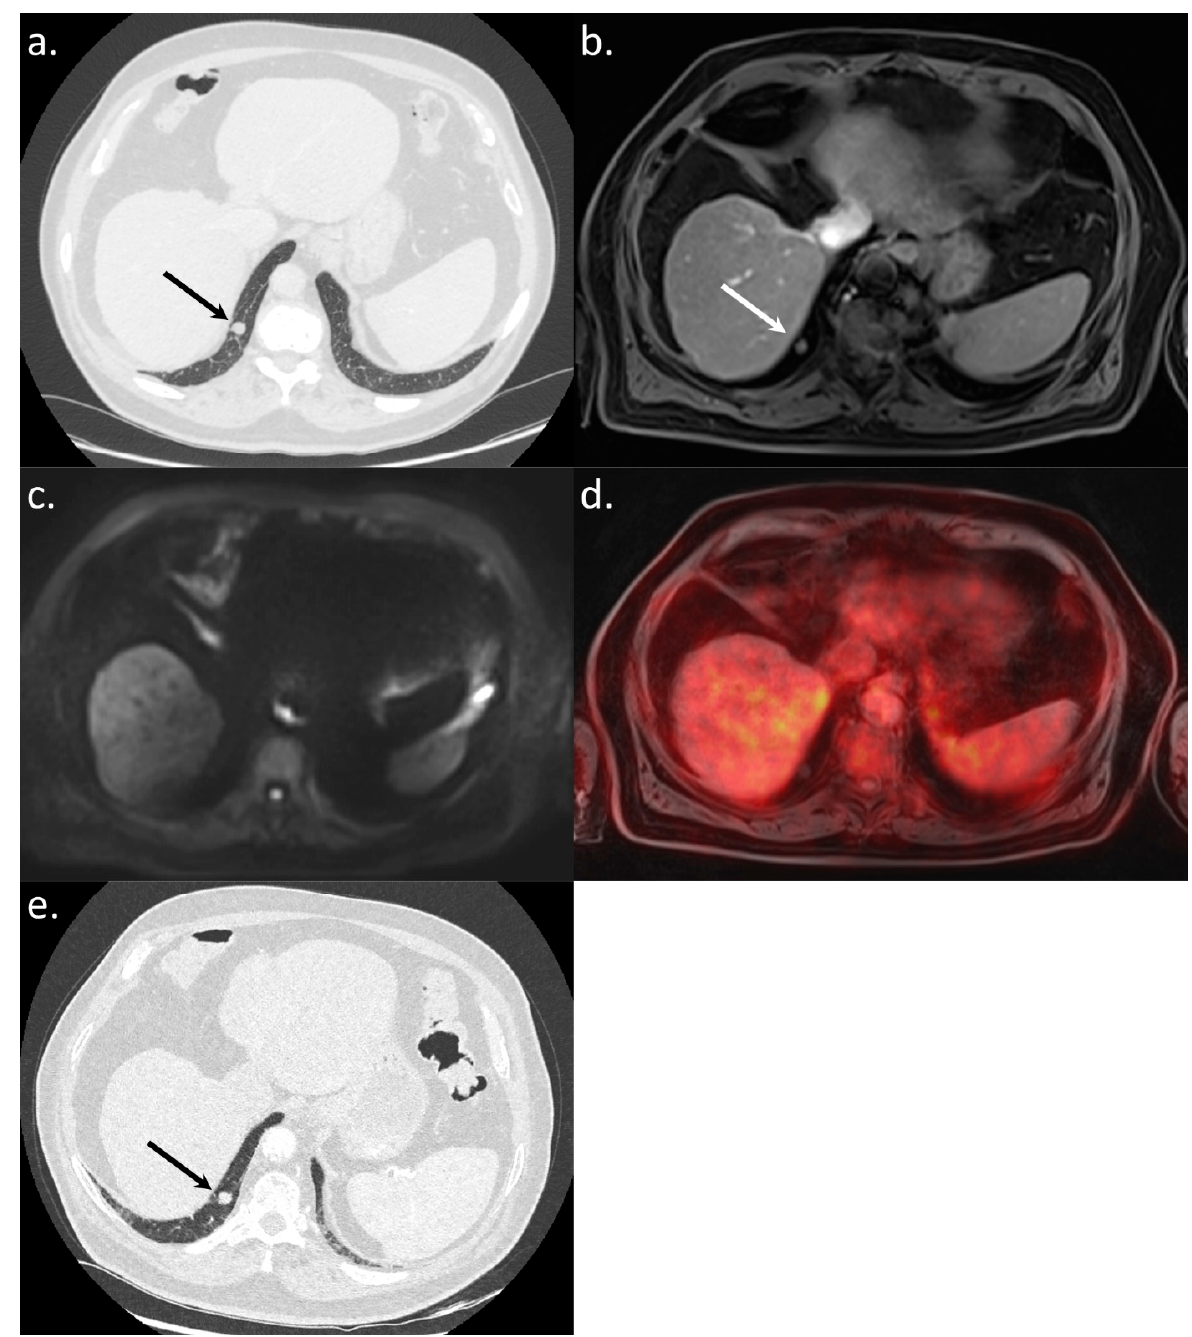
Figure 6. An 82-year-old BCLC A patient referred for a WB-PET/MRI before liver surgery for HCC. The CT-CAP showed an 11 mm large round-shaped pulmonary nodule ( a ). The nodule was also visible on the morphologic MRI sequence ( b ). There was no diffusion restriction ( c ) and no 18 F-FDG hypermetabolism ( d ) leading to the exclusion of lung metastasis. Surgery was performed and, on CT followup performed two years after the WB-PET/MRI ( e ), the nodule remained stable without the appearance of additional lesions.